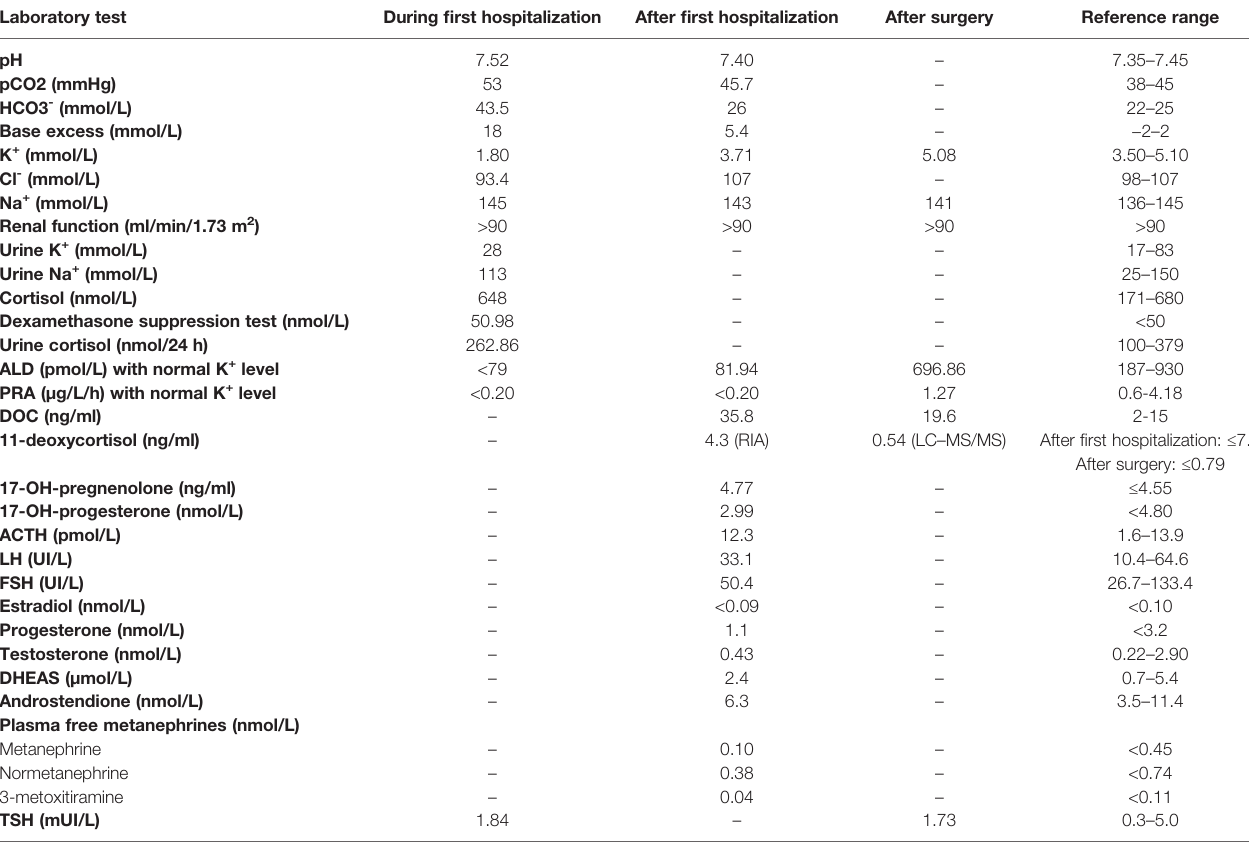
TABLE 1 | Summary of biochemistry results before (during and after the fi rst hospitalization) and after surgery. Laboratory